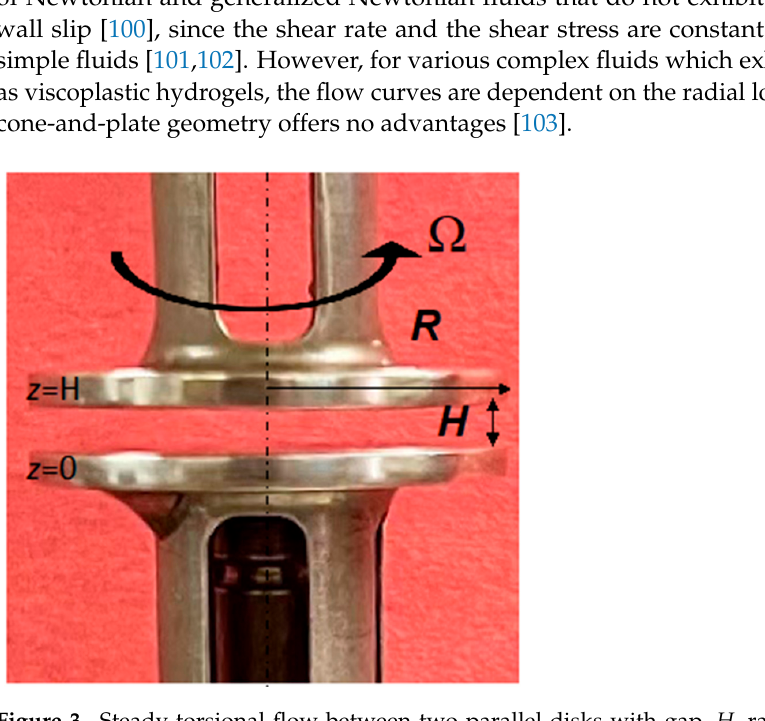
Figure 3. Steady torsional flow between two parallel disks with gap, H , radius, R and Ω is the rotational speed.